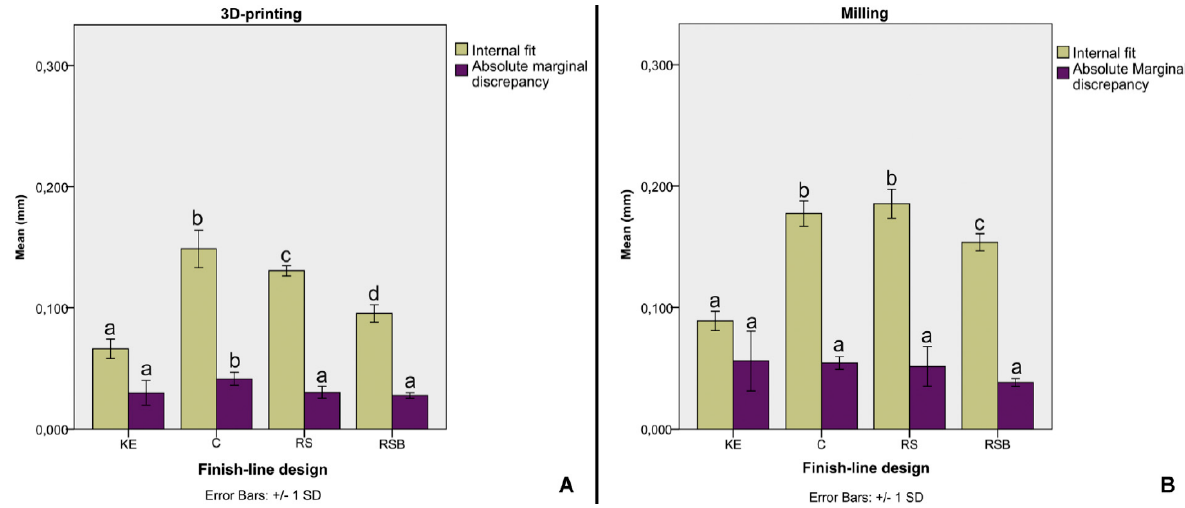
Figure 4. Influence of finish line design on internal fit and AMD in ( A ) 3D printing and ( B ) in milling. Different letters indicate statistical significance between different finish line designs. The figure is adapted from ref. [58], with permission from Elsevier.